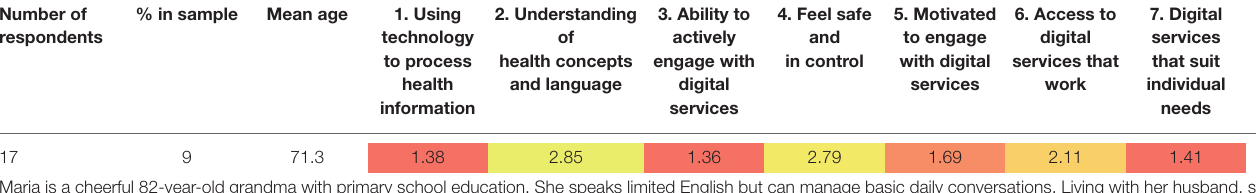
TABLE 6 | Example of a vignette – Cluster G (Maria) of Site 1. Number of